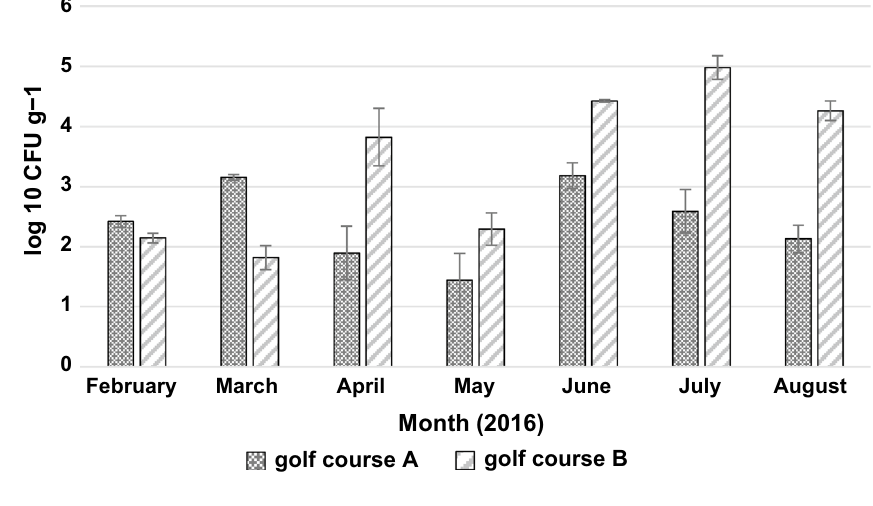
Table 4 Descriptive statistics of the faecal indicators in the soil and turfgrass samples according to the UV-TW and FW irrigation